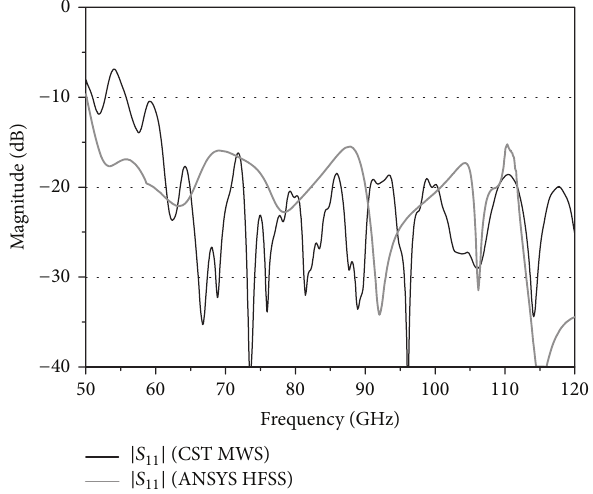
Figure 3: Simulated S-parameters of the antenna.